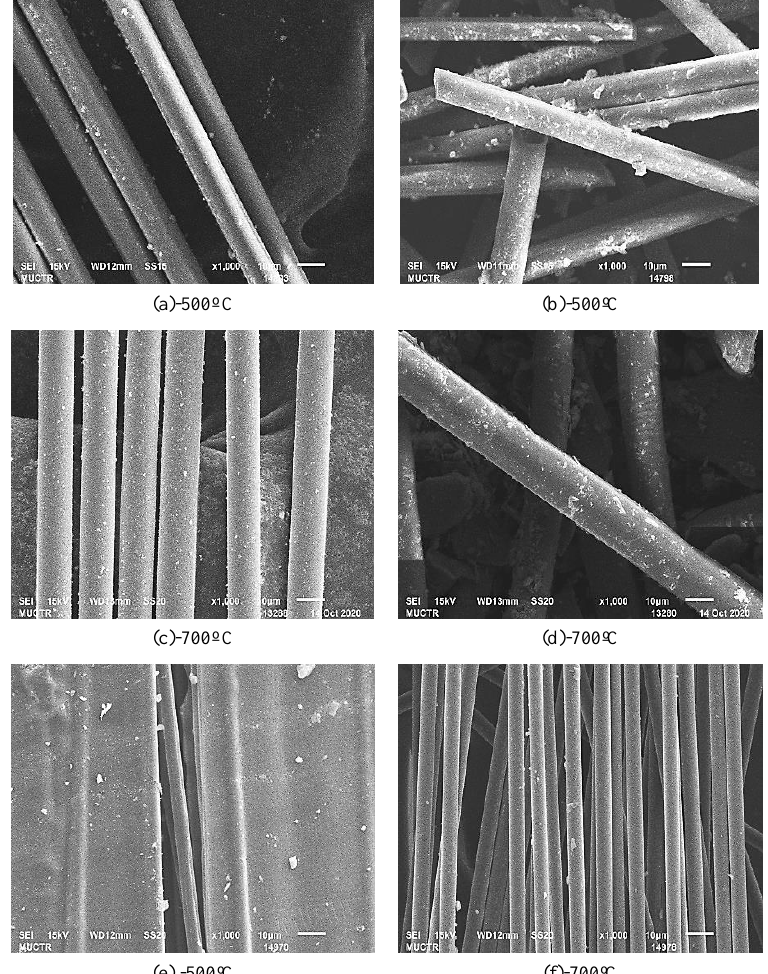
Figure 6. SEM photos (×1000) of thermally recovered glass fibers (a, c – laminate; b, d–office equipment) and carbon fibers (e, f – sample